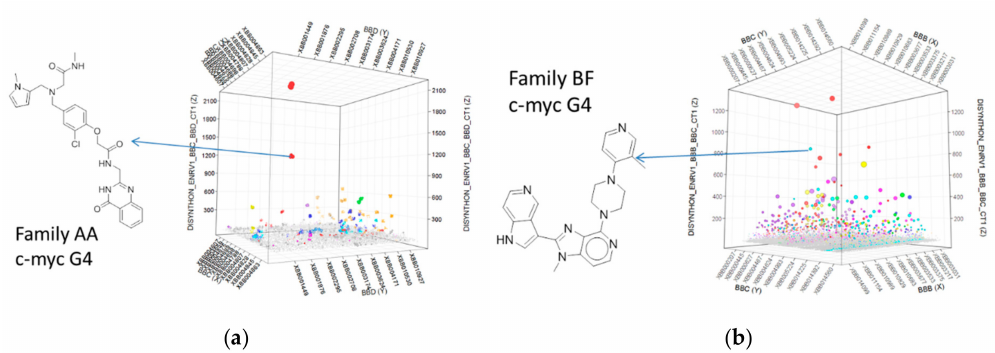
Figure 2. 3D scatter plots showing individual enriched features against the c-myc G4 oligonucleotide. ThesewereusedtoinformthedesignofcompoundsforresynthesizedwithoutDNAattached. ( a )Library A, with Family AA in red; ( b ) Library B, with Family BF in cerulean blue. Arrows indicate which of the enriched features represent the resynthesized active compounds. The x and y axes represent individual building blocks at the indicated cycles of synthesis. The z axis represents a statistical metric of enrichment significance (ENRv1) for each disynthon (negative log 10 of the asymptotic significance value).